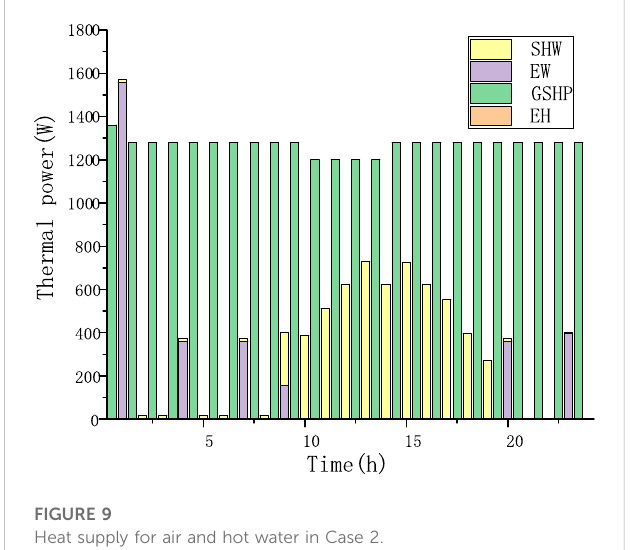
FIGURE 9 Heat supply for air and hot water in Case 2.